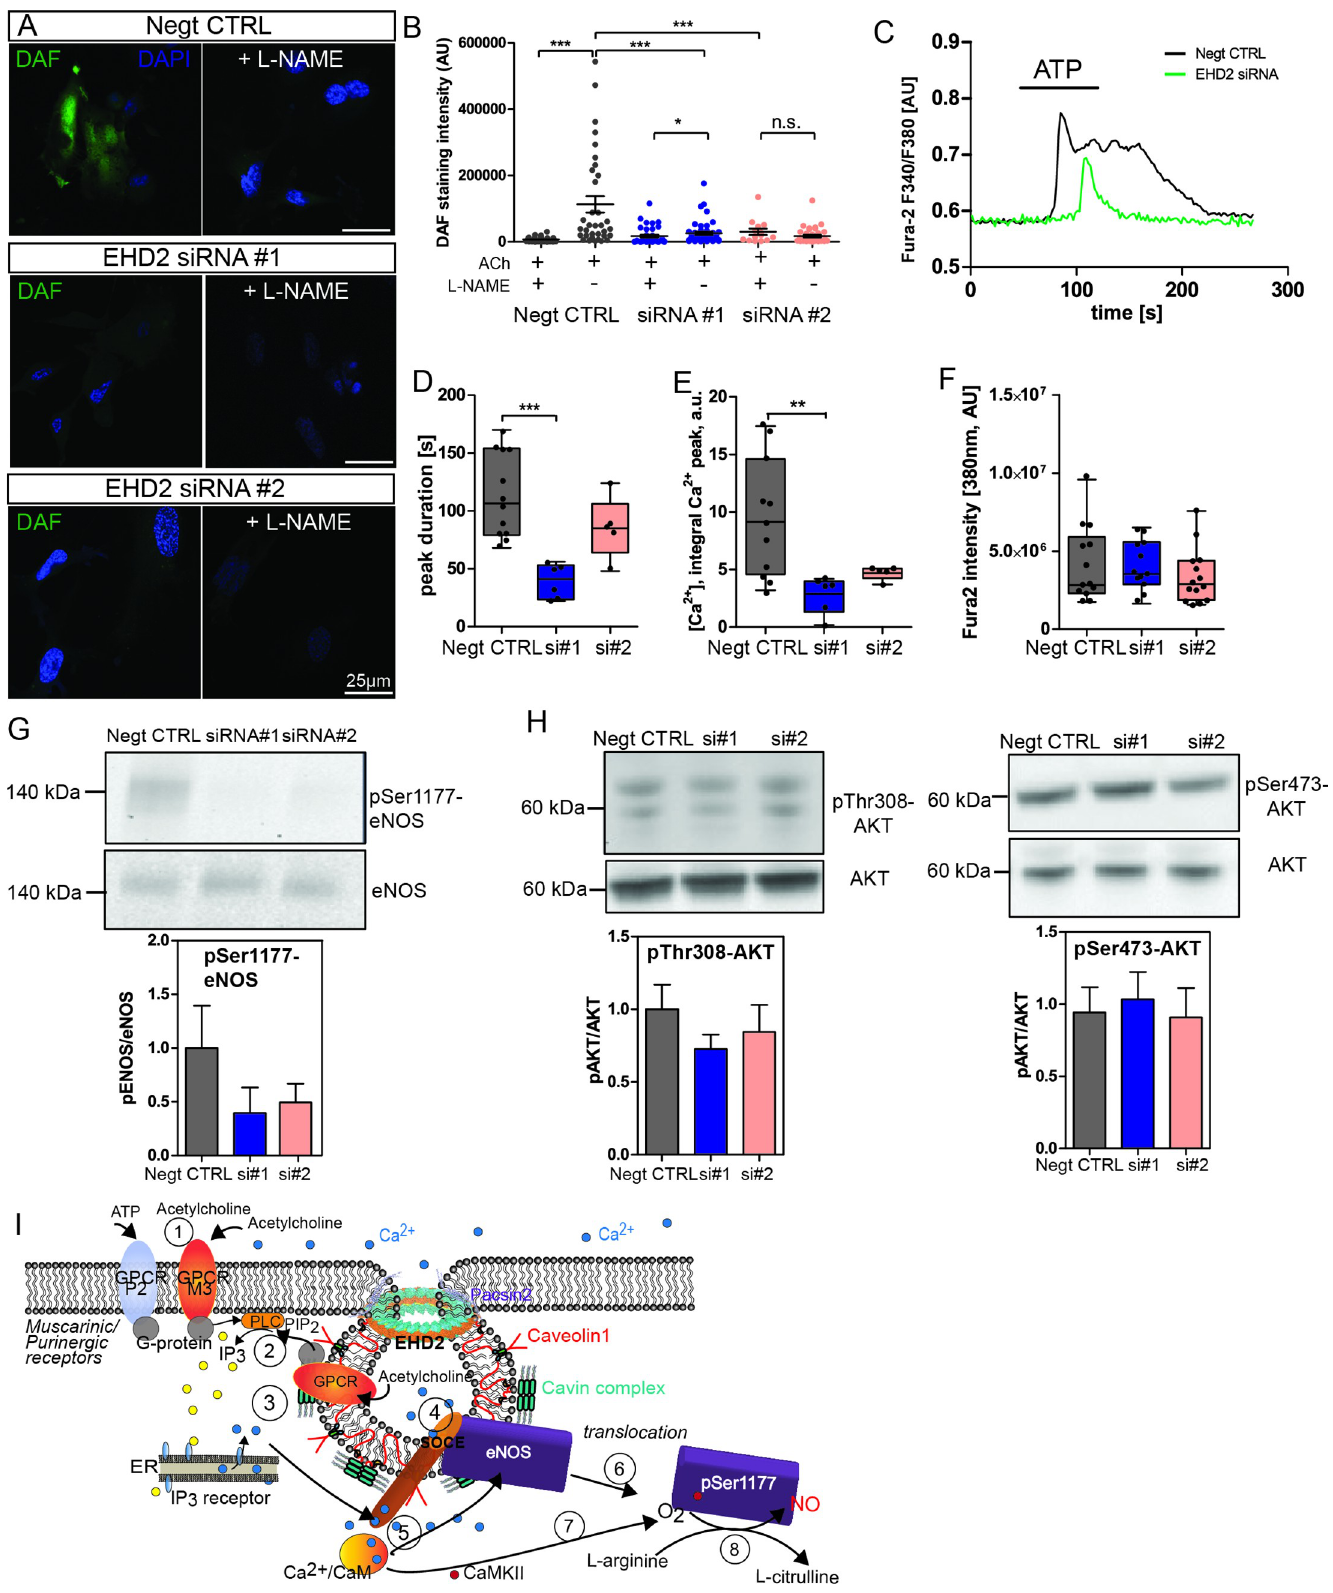
Fig 5. EHD2 siRNA treated HUVEC showed decreased NO generation and cytosolic Ca 2+ response. (A) DAF staining of either non-sense siRNA or EHD2 siRNA (siRNA#1 or siRNA#2) treated HUVECs after acetylcholine stimulation revealed significantly reduced DAF fluorescence intensity in EHD2 siRNA-treated HUVECs. (B) Pre-incubation with L-NAME abolished NO production in all investigated HUVECs (L-NAME: n(Negt. CTRL) = 34/3, n(siRNA#1) = 37/3; n(siRNA#2) = 14/3);